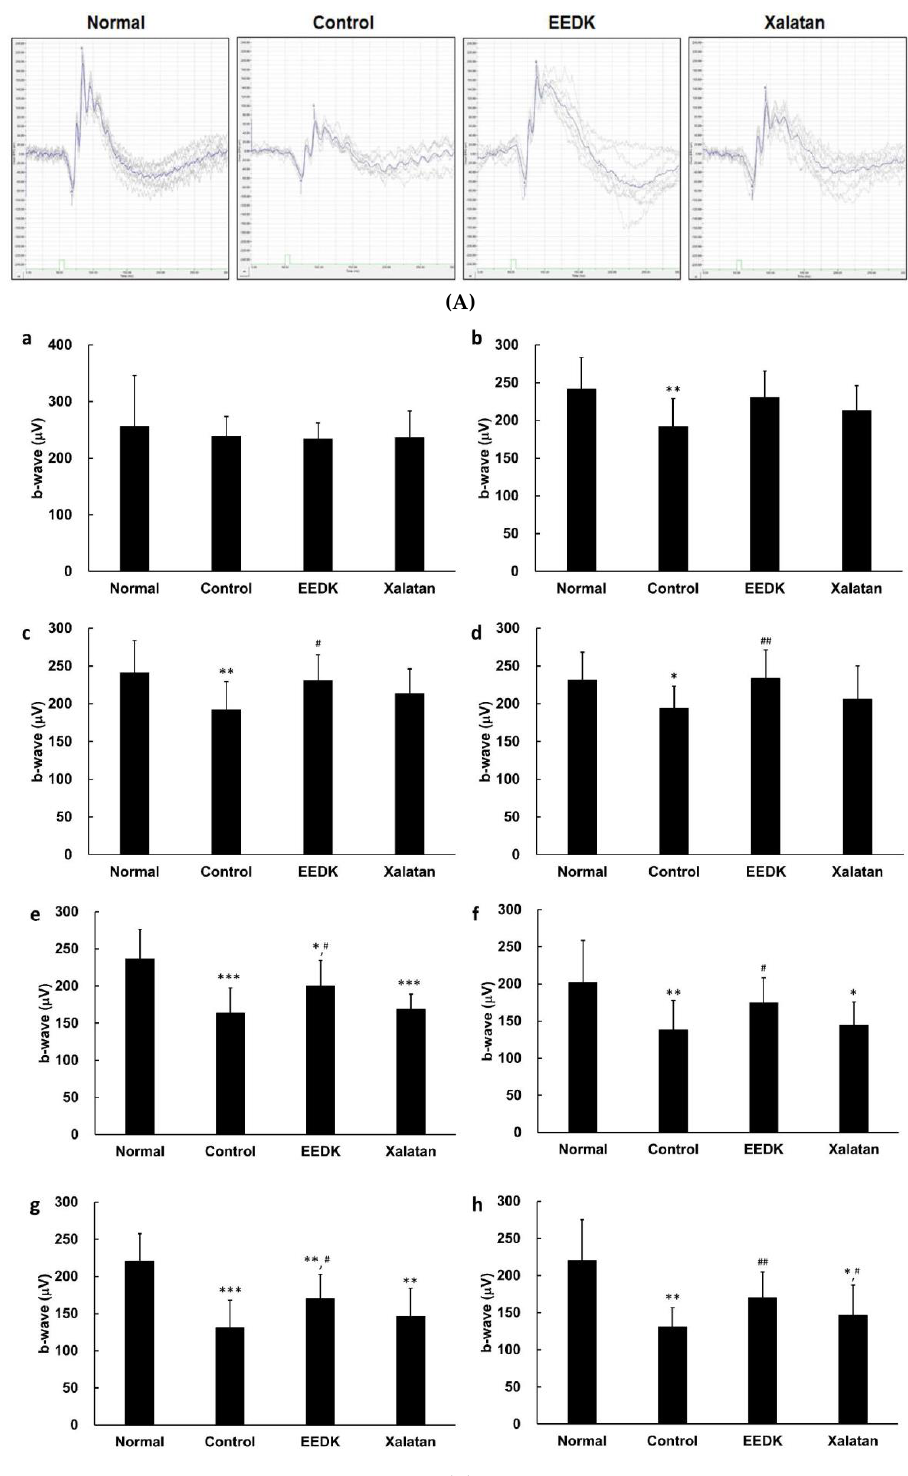
Figure 5. E ff ect of EEDK on b-wave amplitude in DBA / 2 mouse. ( A ) Representative scotopic ERG graph. ( B ) B-wave amplitudes in scotopic conditions were analyzed by ERG at week 0 (a), week 2 (b), week 4 (c), week 6 (d), week 7 (e), week 8 (f), week 9 (g), and week 10 (h). Values represent the mean ± S.E.M. for 10 animals. The values of * p < 0.05, ** p < 0.01 and *** p < 0.001 indicate significant di ff erence when comparing with normal group; meanwhile, # p < 0.05 and ## p < 0.01 indicate significant di ff erence of EEDK or Xalatan-administered group compared with control